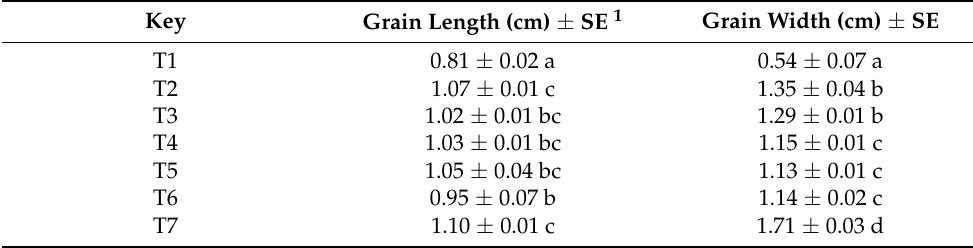
Table 6. Data on the length and grain width of the ears of the Kculli